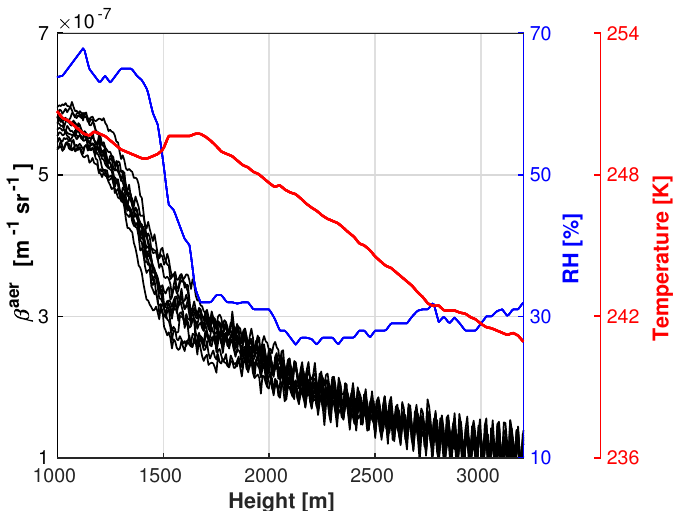
Figure 8. Atmospheric conditions on 13 January 2020. Meteorological data RH (in blue) and tem- perature (in red) from RS launch at 11:00UTC, and lidar data β aer from (10:21–12:14)UTC (in black). The resolution of the lidar data is 10 min and 7.5 m.